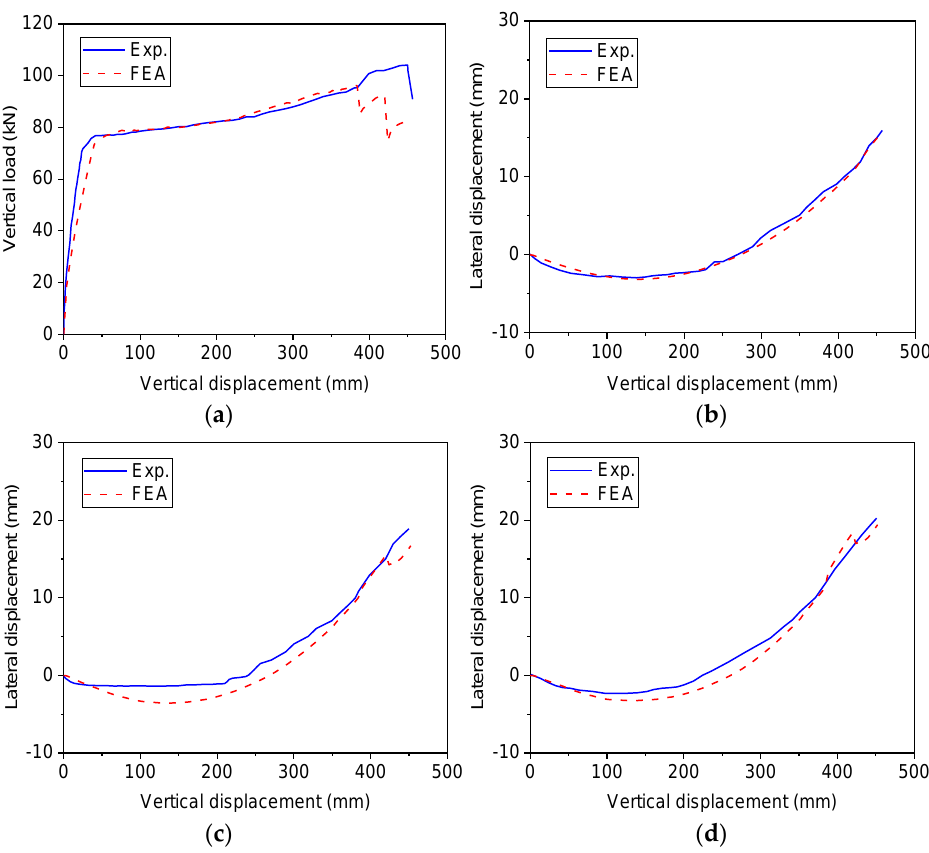
Figure 13. Comparisons between experimental and numerical results of three-storey frames: ( a ) load–displacement curve; ( b ) lateral displacement of first-storey column; ( c ) lateral displacement of second-storey column; ( d ) lateral displacement of third-storey column.